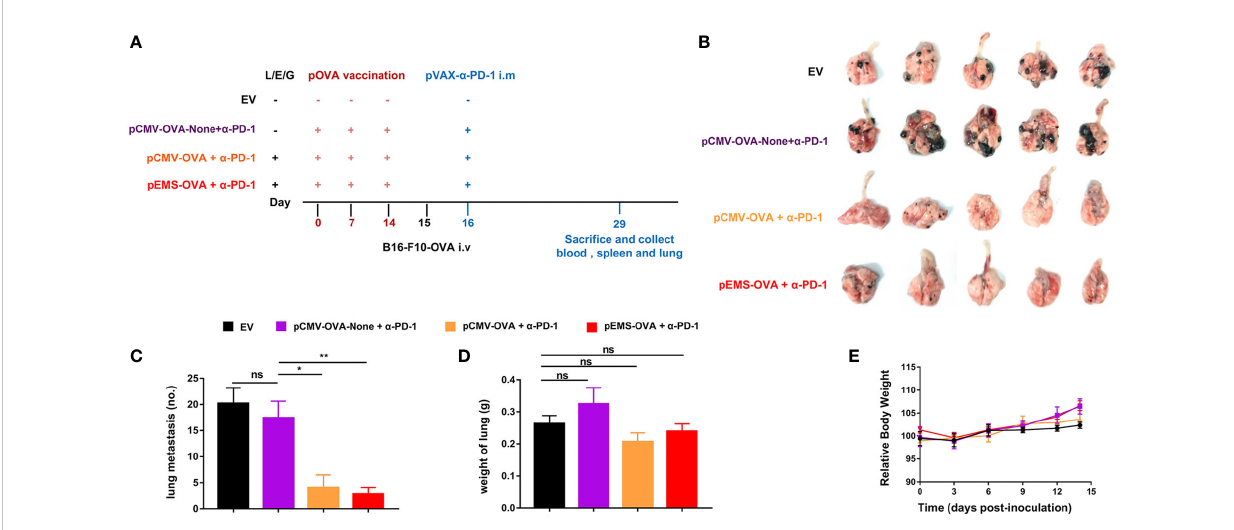
FIGURE 4 Lung metastasis inhibition of combination DNA vaccination and intramuscular gene transfer of PD-1 antibody in B16F10-OVA model. (A) Schematic protocol of the B16F10-OVA inoculation and combination therapy of DNA vaccination with pVAX- a -PD-1-Fc. C57BL/6 mice were divided into four groups: the combination of pOVA vaccine with a -PD-1 antibody (pCMV-OVA + a -PD-1 and pEMS-OVA + a -PD-1), the combination of vaccine without L/E/G and a -PD-1 (pCMV-OVA-none + a -PD-1) and no vaccine (empty vector). N = 5 per group. (B) Images of lung metastasis taken 2 weeks after B16F10-OVA inoculation. Number of metastases nodules on the surface of lung (C) and the wet weight of lungs (D) of the four groups. (E) Relative body weight change of mice receiving four different treatments. The data (C – E) represent the means ± SDs and were subjected to a one-way ANOVA; “ NS ” indicates no signi fi cant difference. *p < 0.05; **p < 0.01. ANOVA, analysis of variance; pluronic L64 (L)/electroporation (E) / epigallocatechin gallate (G) (EGCG) (referred to as